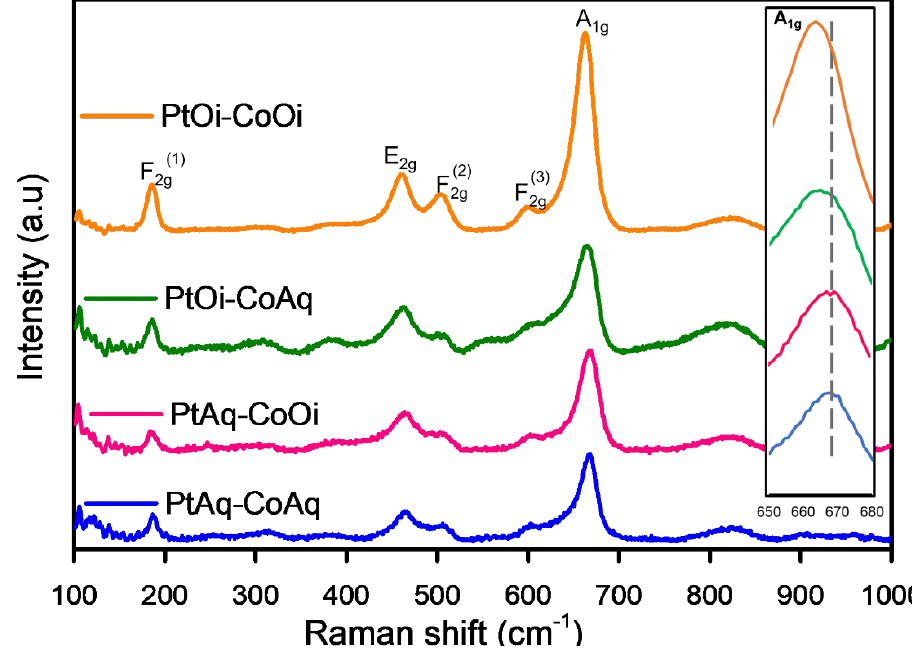
Figure 4. Raman spectra of Pt-Co 3 O 4 -HSs. The inset shows the shift of 𝐴 1𝑔 band towards lower frequency. lower